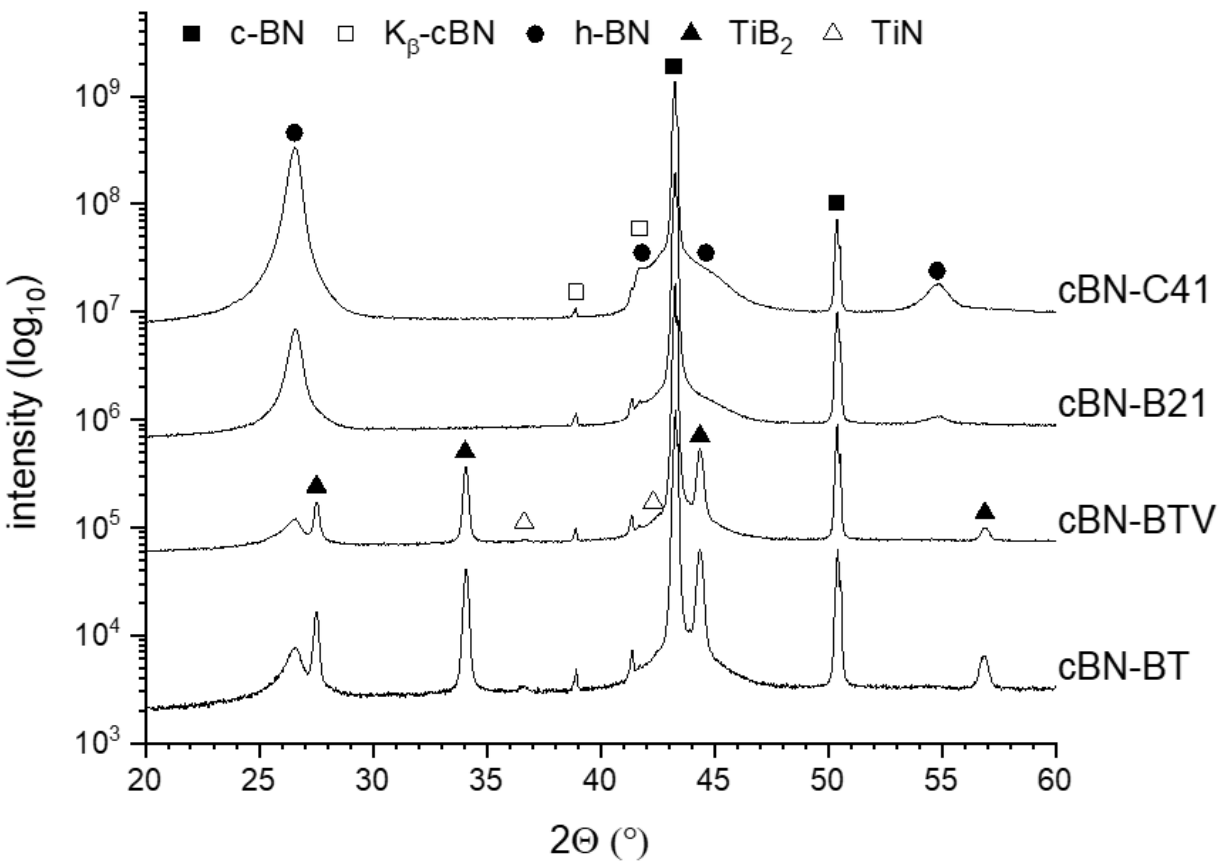
Figure 7. XRD patterns of the investigated cBN powders tempered at 1600 ◦ C under an argon atmosphere (the logarithmic scaling emphasizes the minor phases with low peak intensity).